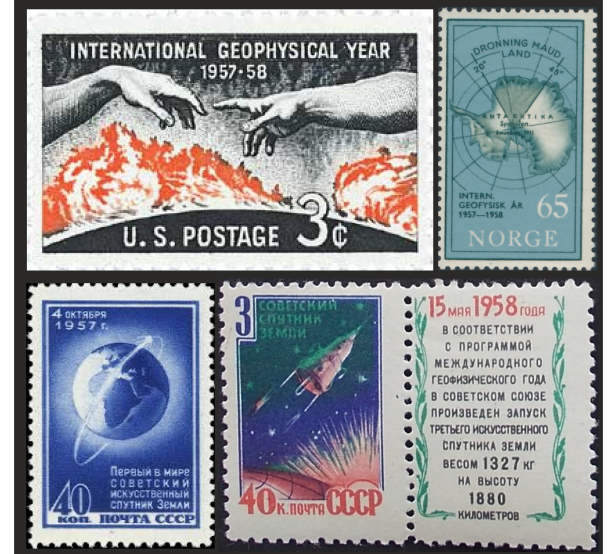
Figure 2. Stamps dedicated to the IGY and produced by the USA (the upper left stamp), Norway (the upper right stamp), and the Soviet Union. The texts in Russian of the Soviet stamps read “The pioneer artificial Earth satellite launched by the Soviet Union” (the lower left panel) and “According to the Interna- tional Geophysical Year program, the Soviet Union launched on 15 May 1958 the third artificial Earth satellite of 1327kg to a height of 1880km” (the lower right panel). The images of the stamps are from the Internet